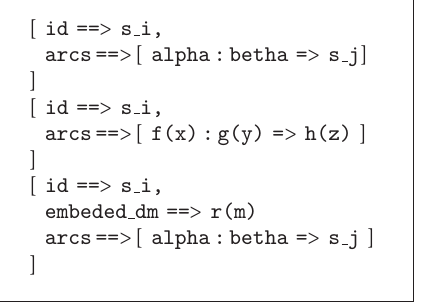
Algorithm 1: Example of code for SitLog: (a) typical SitLog arc, (b) functional arc, and (c) recursive situation.